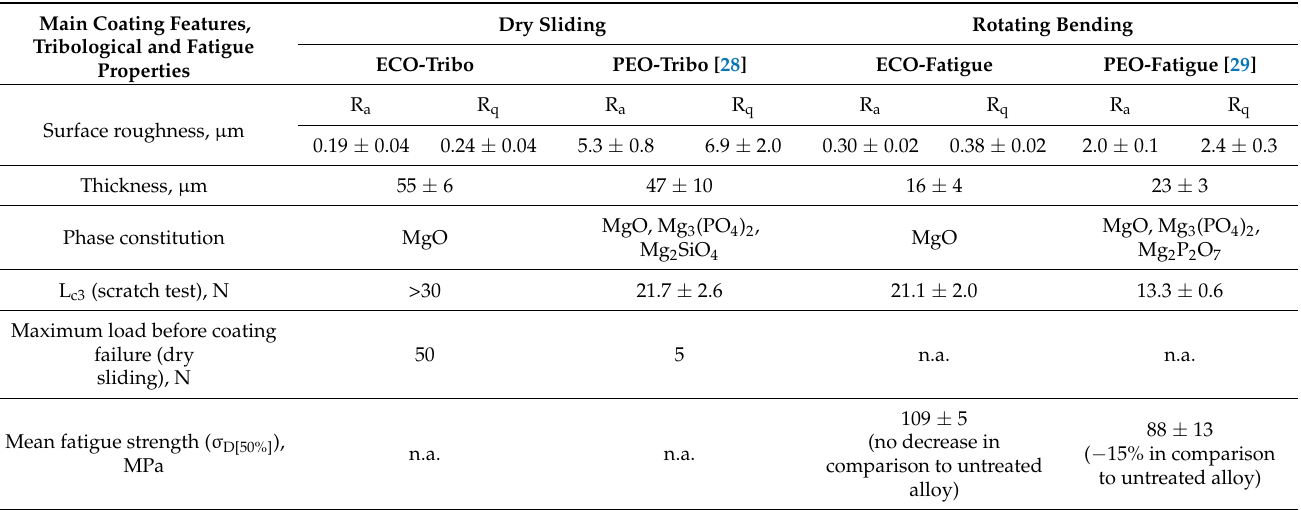
Table 3. Main features of the ECO layers and PEO benchmarks investigated by tribological (dry sliding) and fatigue (4-point rotating bending, staircase method) tests. Results on benchmarks come from our previous studies on the tribological [28] and fatigue [29] behavior of PEO-treated